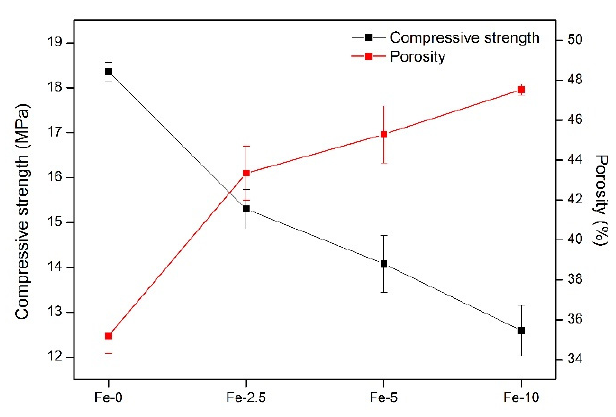
Figure 2. Compressive strength and porosity of Fe-0, Fe-2.5, Fe-5 and Fe-10 bone cement samples.